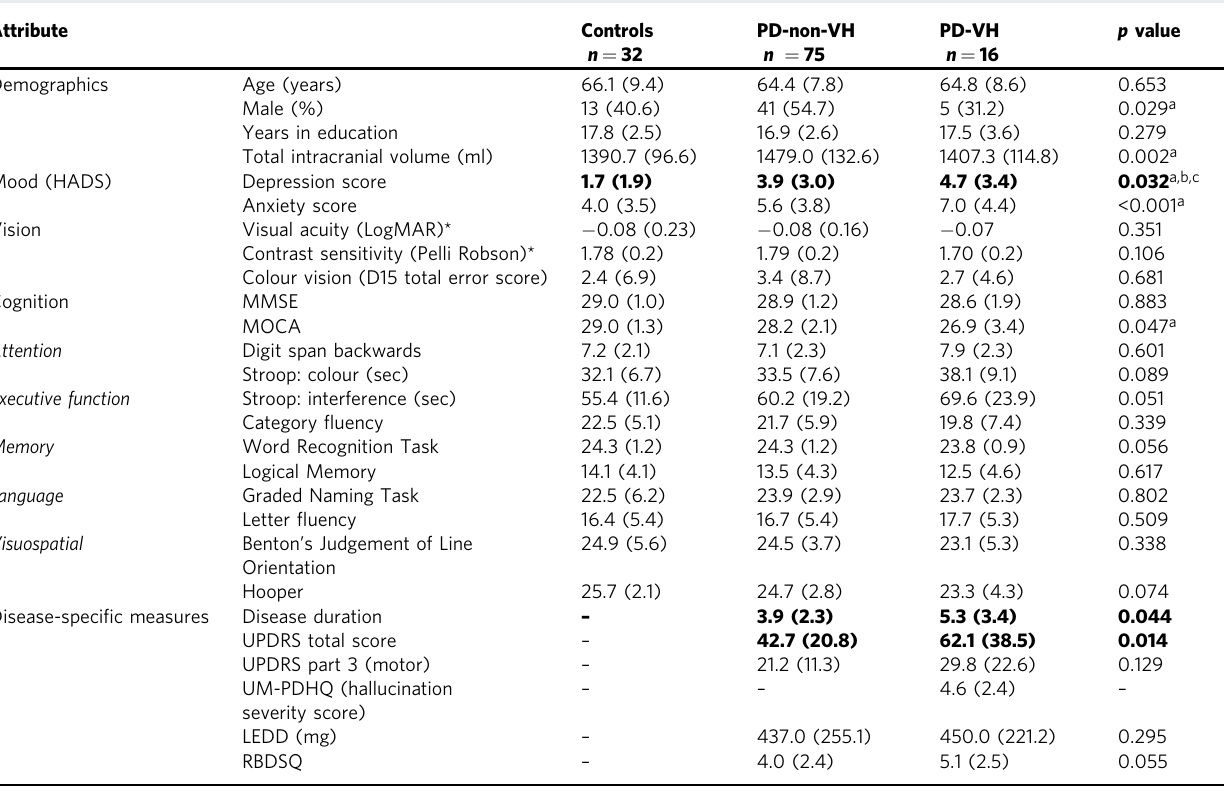
Table 1 Demographics and clinical assessments in patients with Parkinson ’ s with hallucinations (PD-VH) and without hallucinations (PD-non-VH).